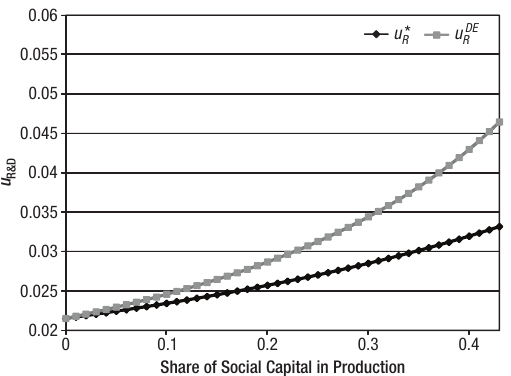
Fig. 3. Comparison between DE of the share of social capital in